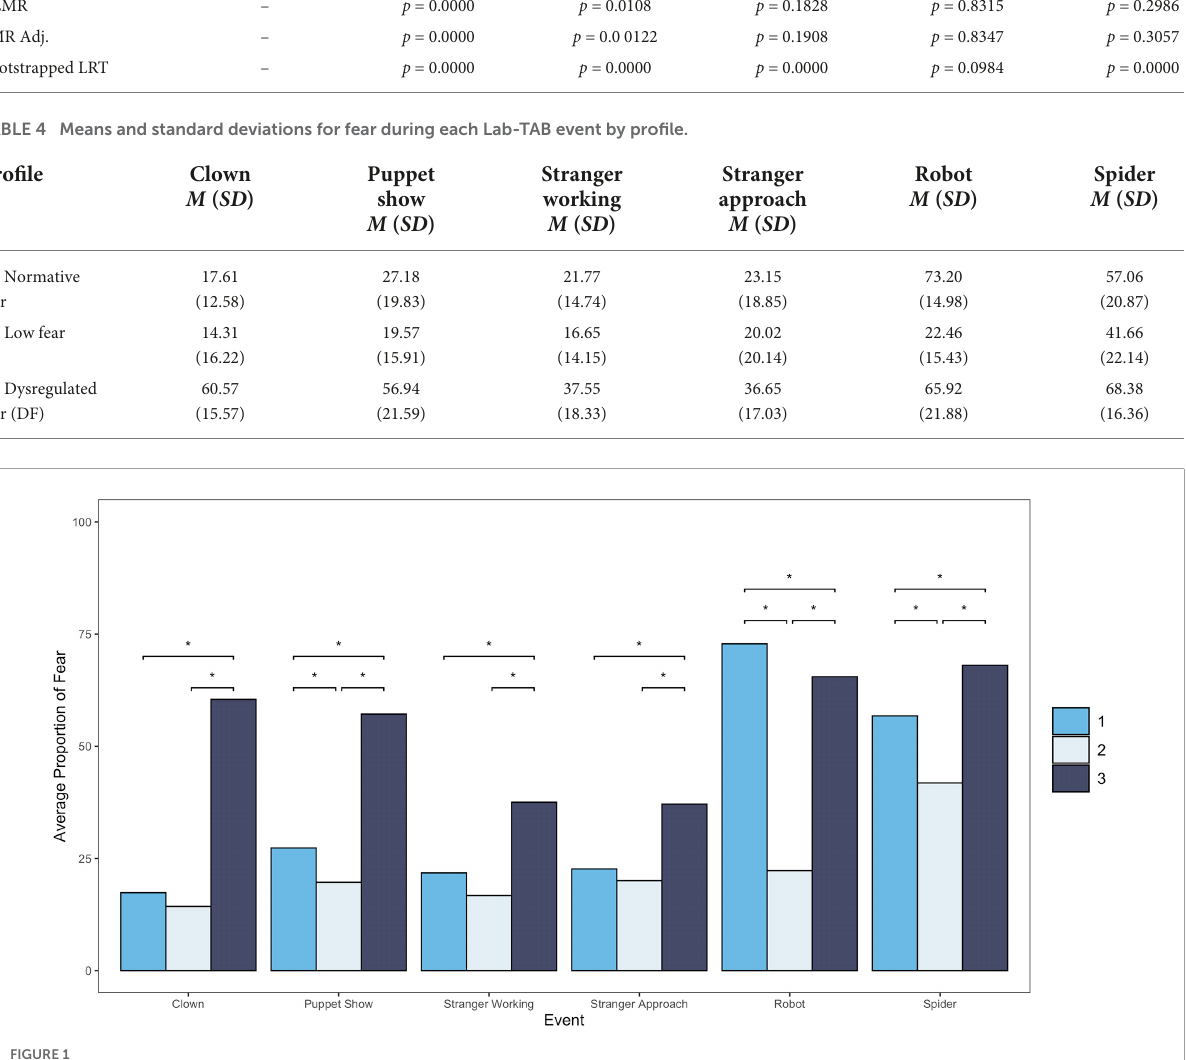
Associations with maternal report A multiple regression with the probability of DF Table 6 contains the results of the multiple regression with probability of membership in the DF profile, child sex,